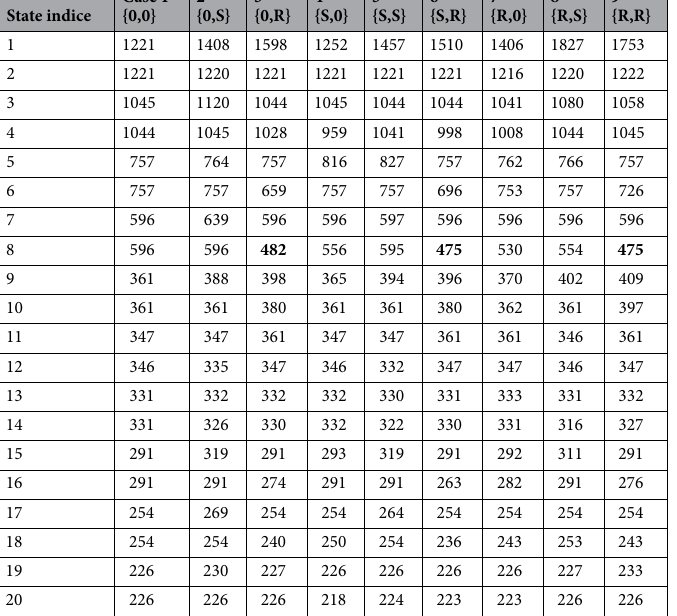
Interpretation of the calculated spectra relative to Fe structure. In cases 3, 6 and 9 of Table 1, which have an R-Gly OH C-terminal bonded to Fe, we noted that there was a good correlation between the cal- culated absorption wavelengths (in the random phase approximation, RPA) and a set of transitions in the Fe II (Fe + ) spectrum. The wavelengths of corresponding states in columns 3, 6 and 9 were averaged and plotted in Fig. 3 against the Fe + (Fe II) transitions 18–20 listed in Table 2. An exact linear correlation was seen, within which the open circles represented transitions of Fe II that were not allowed due to parity, while the solid circles showed allowed transitions. In Fe II there are two close-lying ground states, the Fe II a 4 F 9/2 quasi-ground state lying only 1872 cm −1 above the true ground state a 6 D 9/2 . Many of the calculated molecular transition wavelengths of Table 1 could be traced to an atomic “root” in either the a 4 F 9/2 or the a 6 D 9/2 state of Fe II as listed in Table 2. In confirmation of the Fe charge state, all the ground states listed in Table 2 had a Mulliken charge of 1.06 units, effectively acting as Fe + (Fe II) ions. The calculated strength of the 477.5 nm absorption was 0.0116, averaged over cases 3, 6 and 9, which greatly exceeded the strengths of the other parity-forbidden transitions of Table 2, indicating a moderate strength for the induced absorption at 477.5 nm. Following absorption, re-radiation from this transition would be expected to have a decay life of about 300 ns in the absence of further energy transfer into vibrations of the molecule. An offset of 2050 ± 460 cm −1 in energy was seen between CIS and RPA levels of calculation, with the CIS ener- gies being higher. We identified this constant energy difference with the 1872 cm −1 difference between the two Fe II ground states, indicating a slight difference of outcome between the two methods. As we were able to correlate